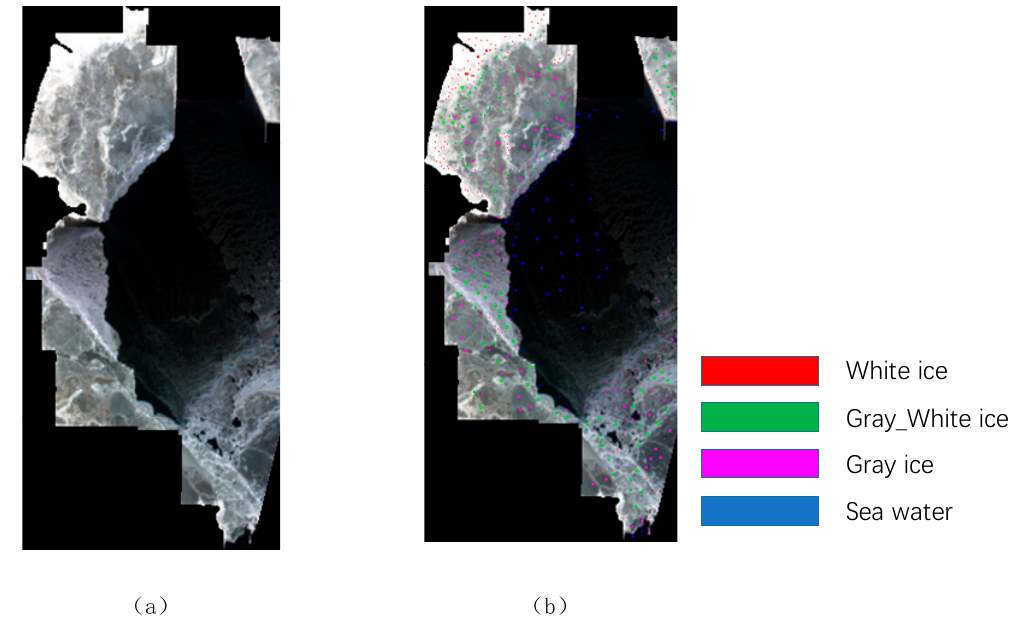
B: 18, and the corresponding labeled samples are shown in Figure 3b. The labeled samples were randomly divided into training samples and test samples at a ratio of 1:9, as shown in